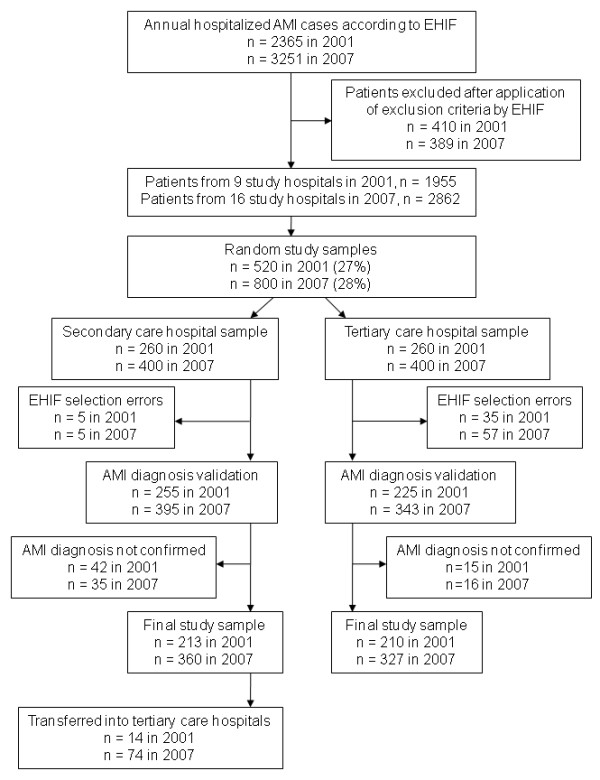
Formation of the study samples in 2001 and 2007. AMI, acute myocardial infarction; EHIF, Estonian Health Insurance Fund.